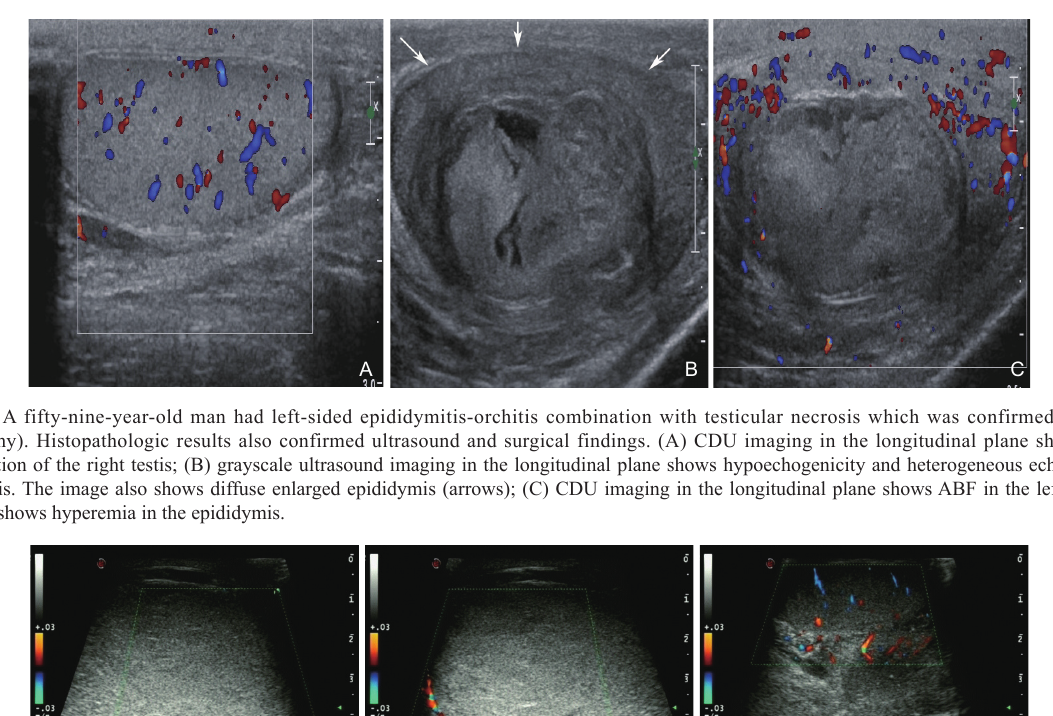
Figure 3 A fifteen-year-old boy had right-sided testicular rupture which was confirmed by surgery (testicular rupture repair surgery). He had a history of right scrotal trauma. (A) CDU imaging in the longitudinal plane shows normal vascularization of the left testis; (B) grayscale ultrasound imaging in the longitudinal plane shows heterogeneous echogenicity and interruption of echogenic tunica albuginea (arrow head) in the right testis. The image also shows scrotal hematoma (arrows); (C) CDU imaging in the longitudinal plane shows ABF in the right testis.